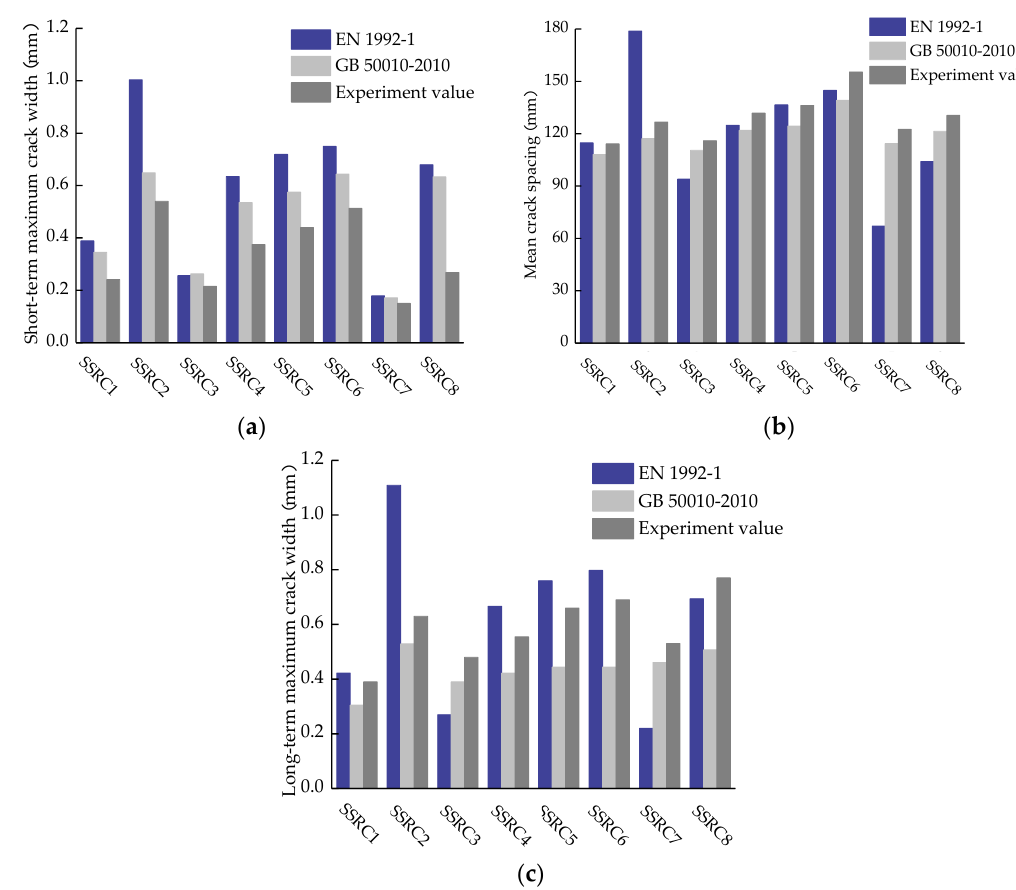
Figure 13. Comparison of calculated results with test results: ( a ) maximum crack widths for short-term load, ( b ) mean crack spacing, and ( c ) maximum crack widths for long-term load.